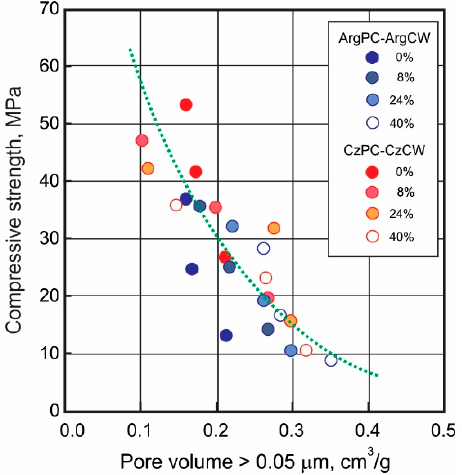
For CzPC-CzCW, the compressive strength of blended cement was reduced with the CW replacement from 2 to 28 days. On day 90, blended cements containing up to 16 wt. % of CW had a similar strength to CzPC. The strength ratio was higher than 0.75 on day 2, 7, and 28 for low (8%), medium (16% and 24 %), and high (32%) cement replacements, respectively. Blended cements with 40 wt. % of CW attained this ratio on day 90.